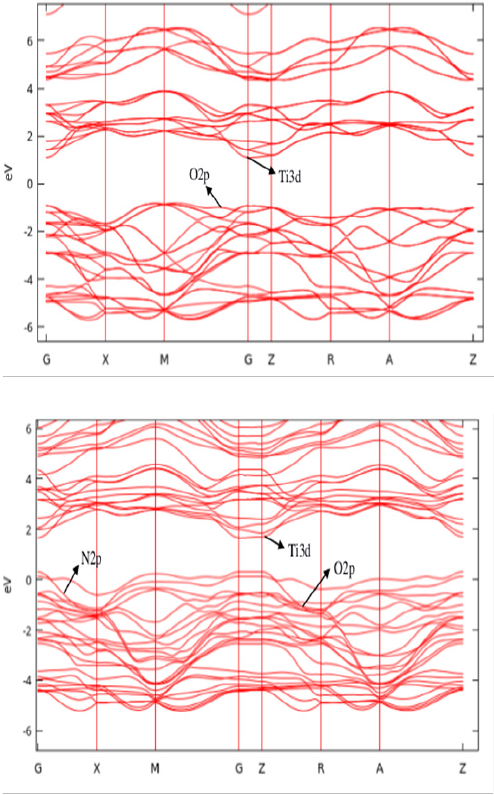
Fig. 12. Band structures of considered TiO2, a: pure and b: